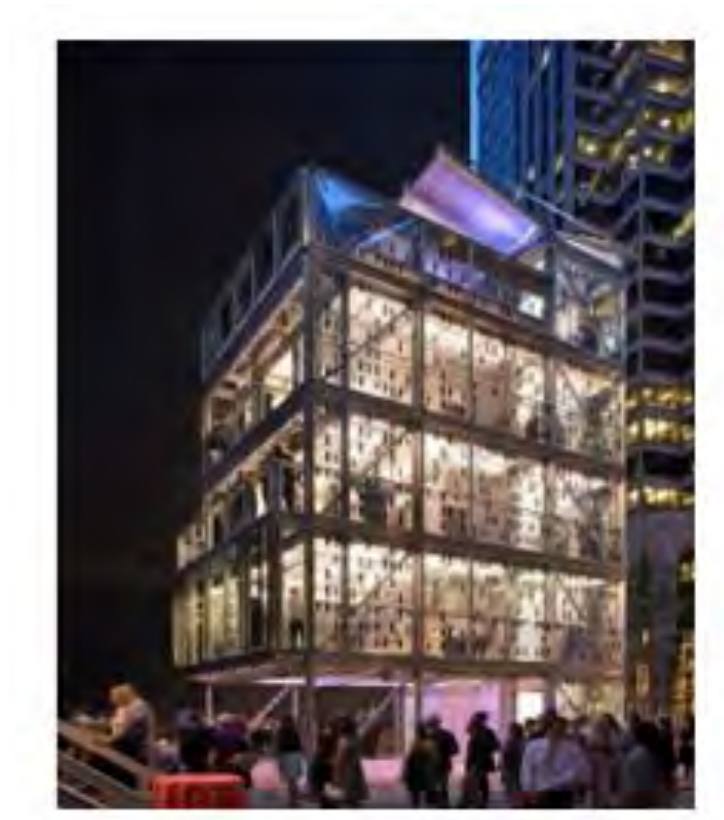
Figure 8. Cellophane House, Smart Wrap, Facade Pane Source (Kieran,